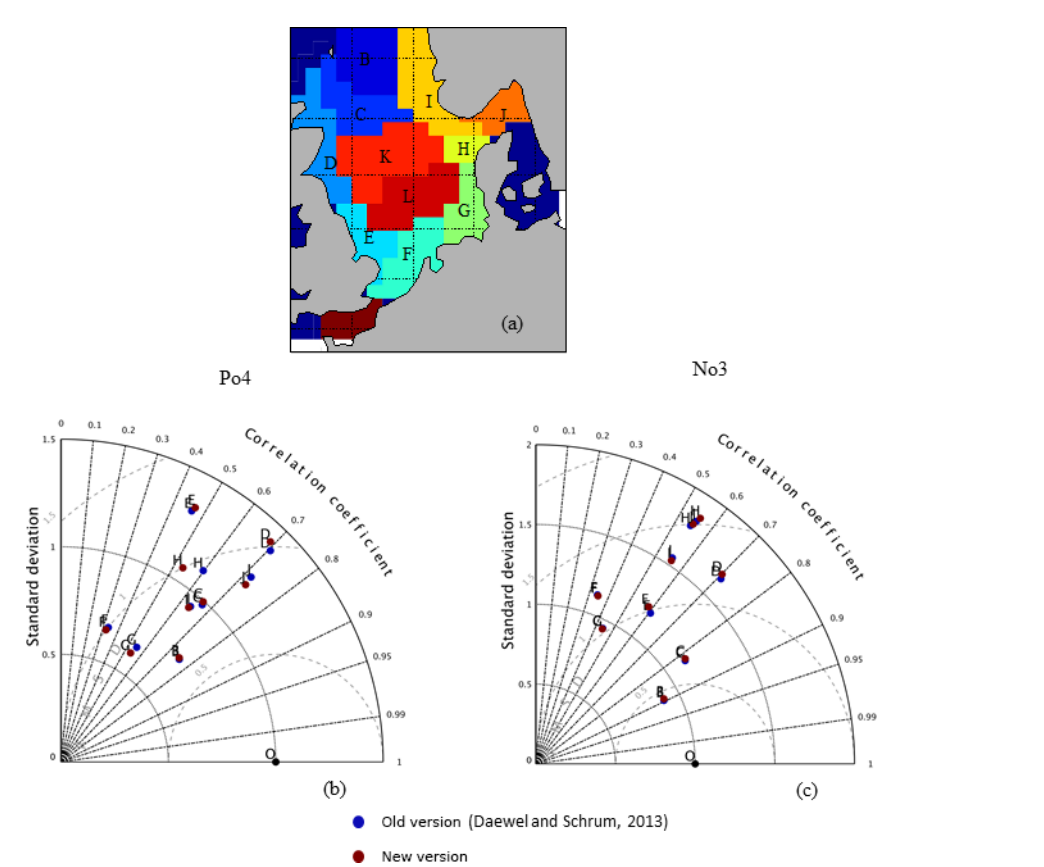
Figure B2. Taylor diagram for surface (above 20m) nutrient validation (model vs. ICES data) in different areas of the North Sea for phosphate (b) and nitrogen (c) . Area separation is given in panel (a)